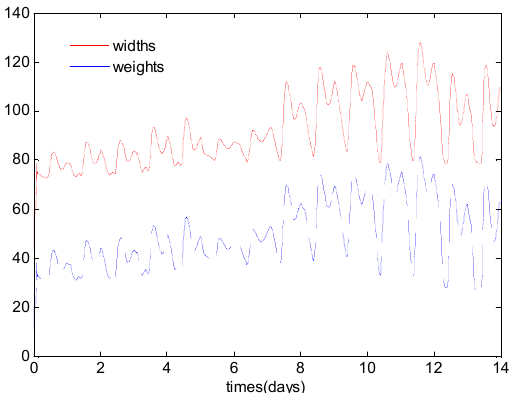
Figure A3. Dynamic changes of the centers of the first neuron (of the hidden layer neurons) of the neural network. (Where, ×1, ×2 and ×3 represent the three centers of the first neuron).